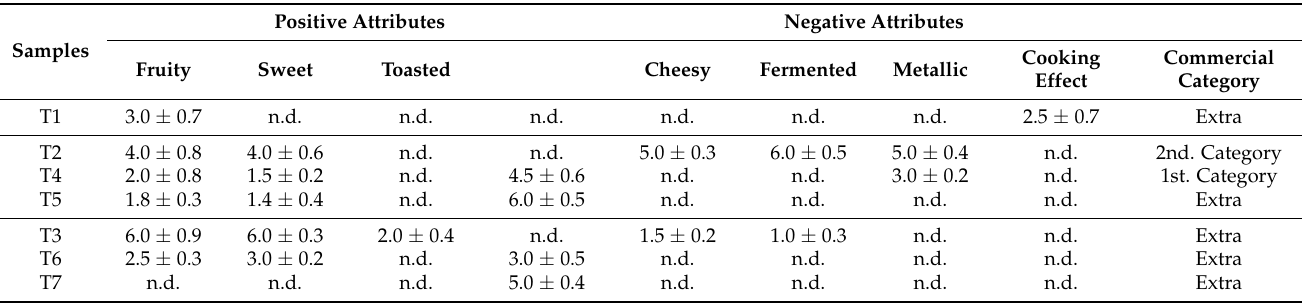
Table 2. Sensory olfactory evaluation of Californian-style black